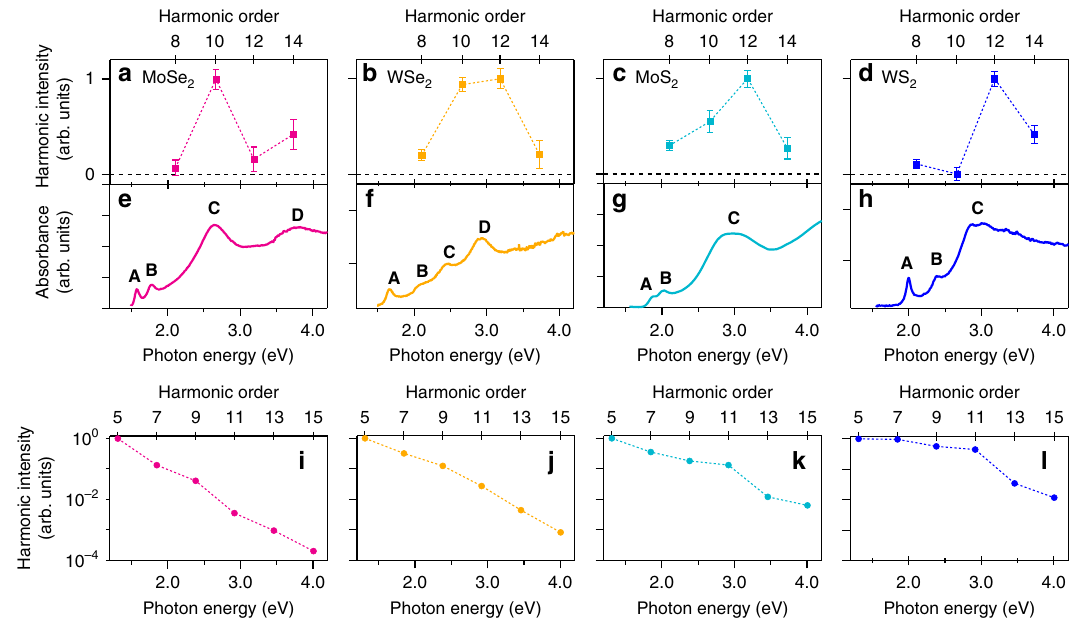
Fig. 2 Resonant enhancement of even-order high harmonics. Intensities of even-order harmonics in a MoSe 2 , b WSe 2 , c MoS 2 , and d WS 2 monolayers. Error bars represent the standard deviations. e , f , g , h Corresponding optical absorption spectra of the TMD monolayers. The peaks of the A and B excitons are labeled A and B, respectively. The peaks due to the band nesting effects are labeled C and D. i , j , k , l Corresponding intensities of odd-order